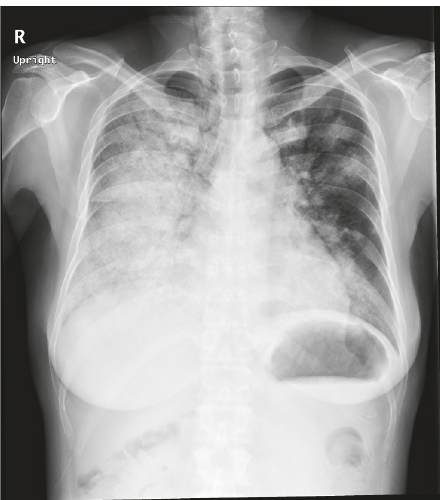
Figure 1: Chest radiograph upon the start of high-dose corticos- teroid therapy. Infiltrative shadows are clearly observed in both lung fields.